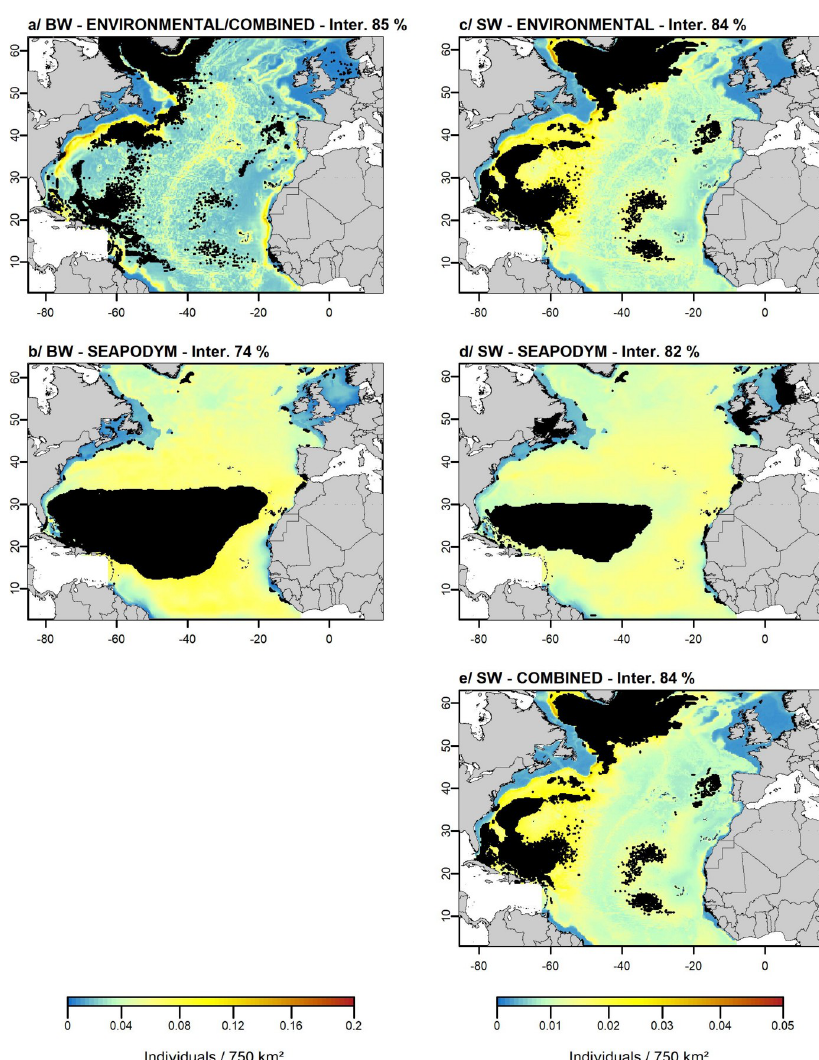
Fig 4. The predicted relative densities of beaked (BW) and sperm (SW) whales obtained from the ENVIRONMENTAL (a, c), SEAPODYM (b, d) and COMBINED (a, e) models. A square root scale has been used to visualise the predictions but the values in the legend represent the untransformed predicted values. The ENVIRONMENTAL and COMBINED models were identical for beaked whales thus represented only once. Black areas on prediction maps represent zones where we did not extrapolate the predictions. Percentages represent the proportion of the study area defined as interpolation (Inter.) with the gap analysis. Base map from https://www.gebco.